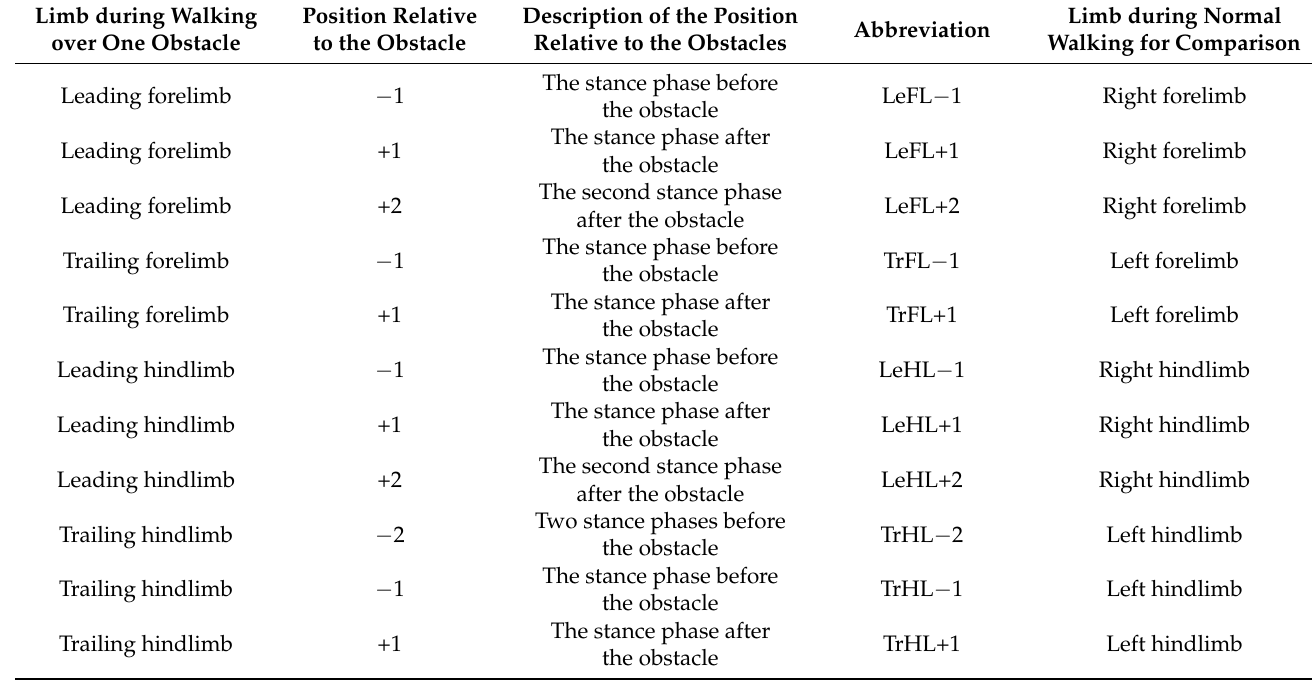
Table 1. Description of the abbreviations used during walking over one obstacle and the limbs with which they were compared during normal walking.